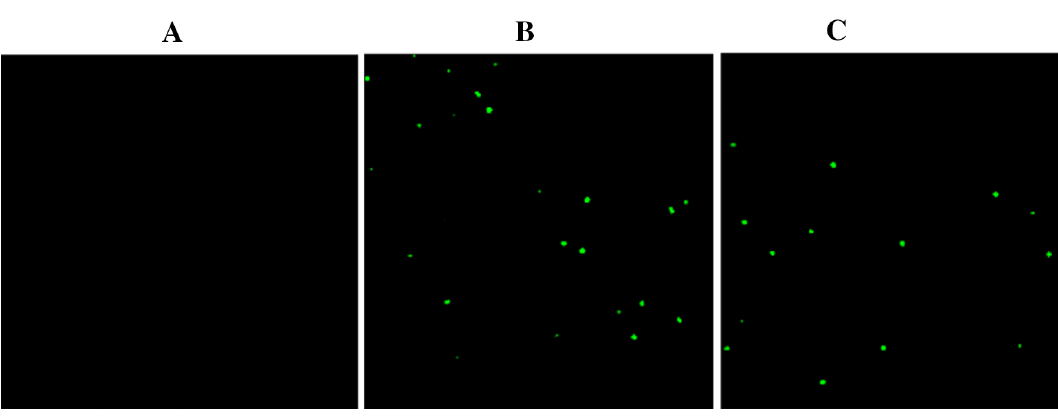
Figure 9. DCF-DA mediated ROS production in E. coli ( A ) control, ( B ) E. coli treated chemical Nps. ( C ) E. coli treated biological synthesized